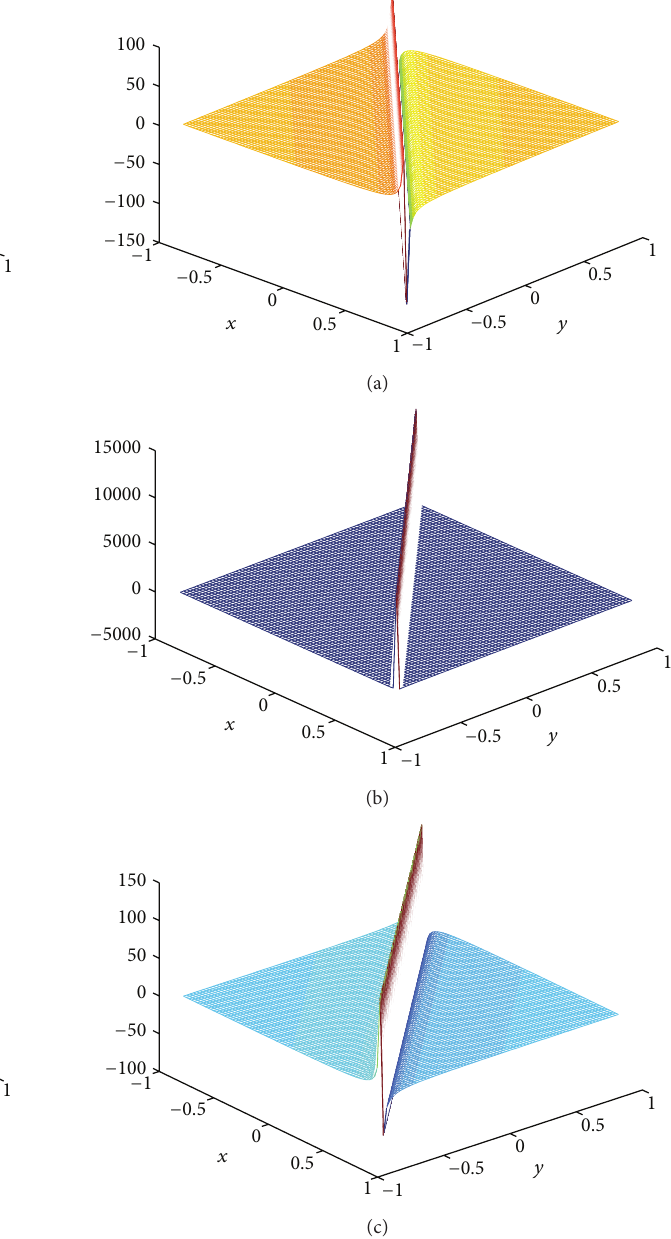
Figure 4: The solution of BLP corresponding to 𝑢 𝑠,4 : take 𝑐 = 1 , = 0 ; (a) 𝑡 = −1/144 , (b) 𝑡 = 0 , and (c) 𝑡 = 1/144 . 𝛼 = 1 , 𝑧 0